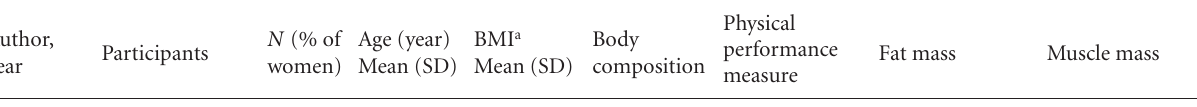
Table 1: Summary of studies examining the relationship between physical performance (PP) and body composition.